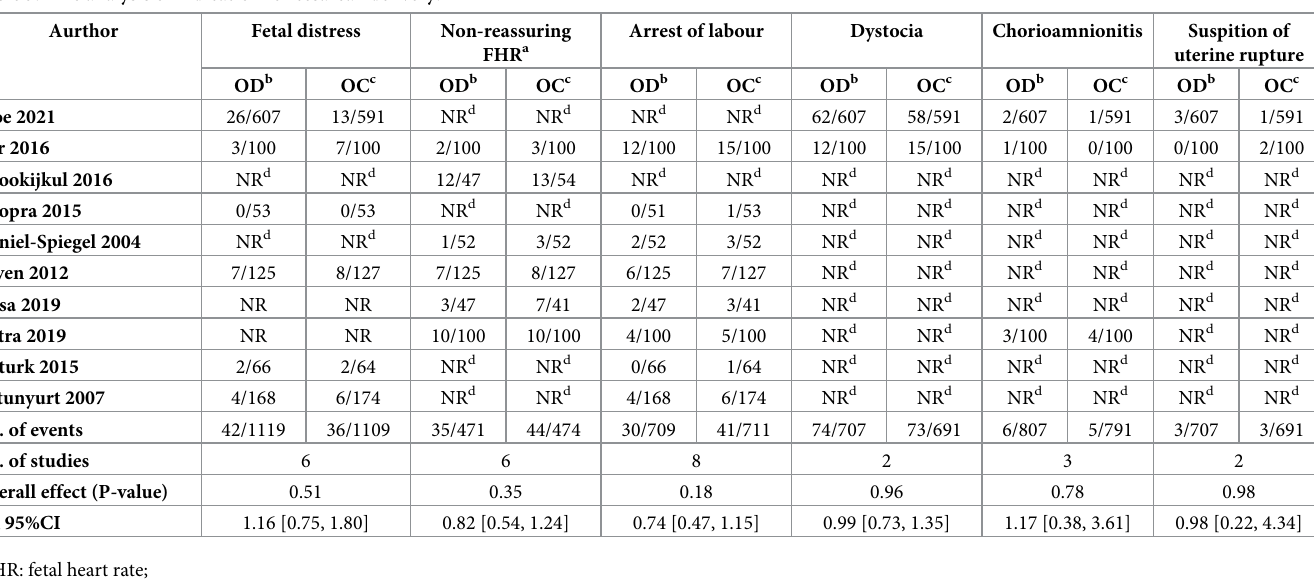
Table 5. The analysis of indication for cesarean